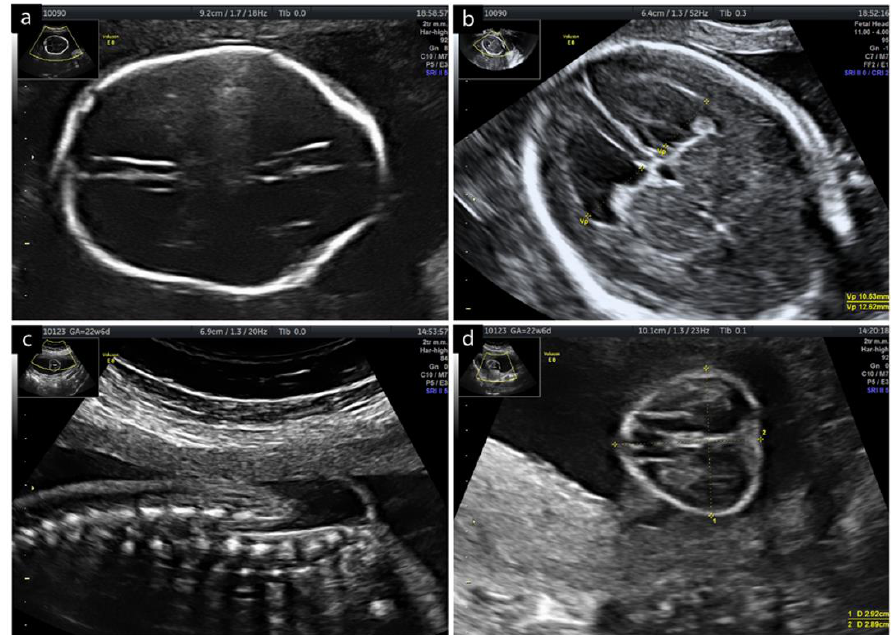
Figure 1. Chiari II malformation visualized on ultrasound at 22.6 weeks of gestation: ( a ) Transverse view of the fetal head: ‘lemon sign’; ( b ) Axial transventricular view of the fetal brain: the calipers indicate the measurements of the ventricular width; ( c ) TSC medullary cone positioned at L 5; ( d ) Transverse view: MMC measurements and placode.